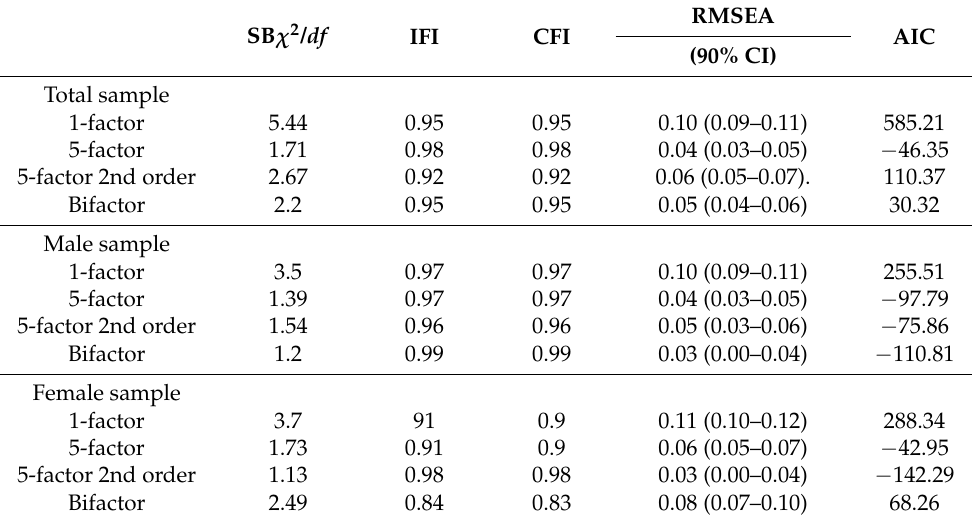
Table 1. Goodness of fit indexes for the different models of the SUPPS-P.